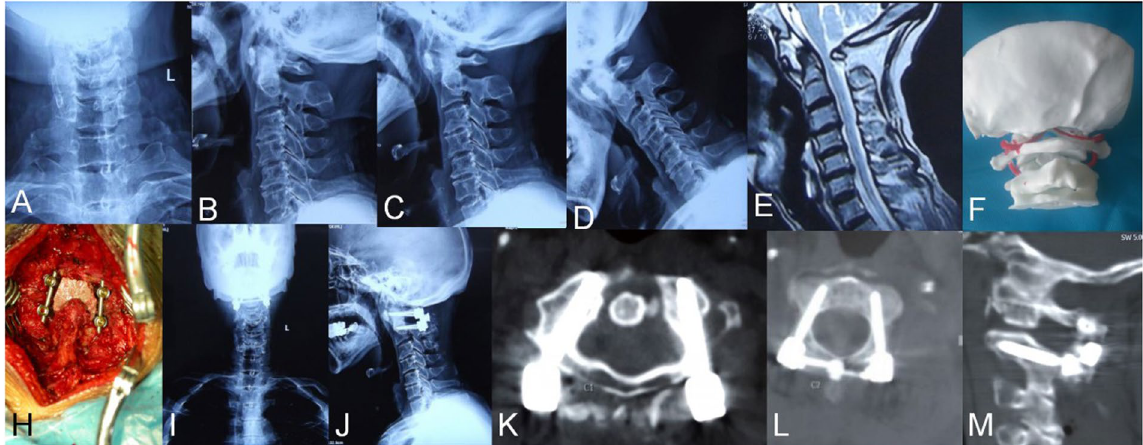
Figure 4. A 47 year-old male with atlantoaxial dislocation received posterior reduction and C1 pedicle-C2 pedicle internal fixation assisted by a 3D-printed life-size model. ( A – D ) Preoperative X-ray photographs showing atlantoaxial dislocation. ( E ) Preoperative MRI showing compression of the spinal cord. ( F ) A life-size C0-2 model. ( H ) Intraoperative photograph. ( I – M ) Postoperative photographs showing that the atlantoaxial dislocation was reduced and that the screw position was satisfactory.